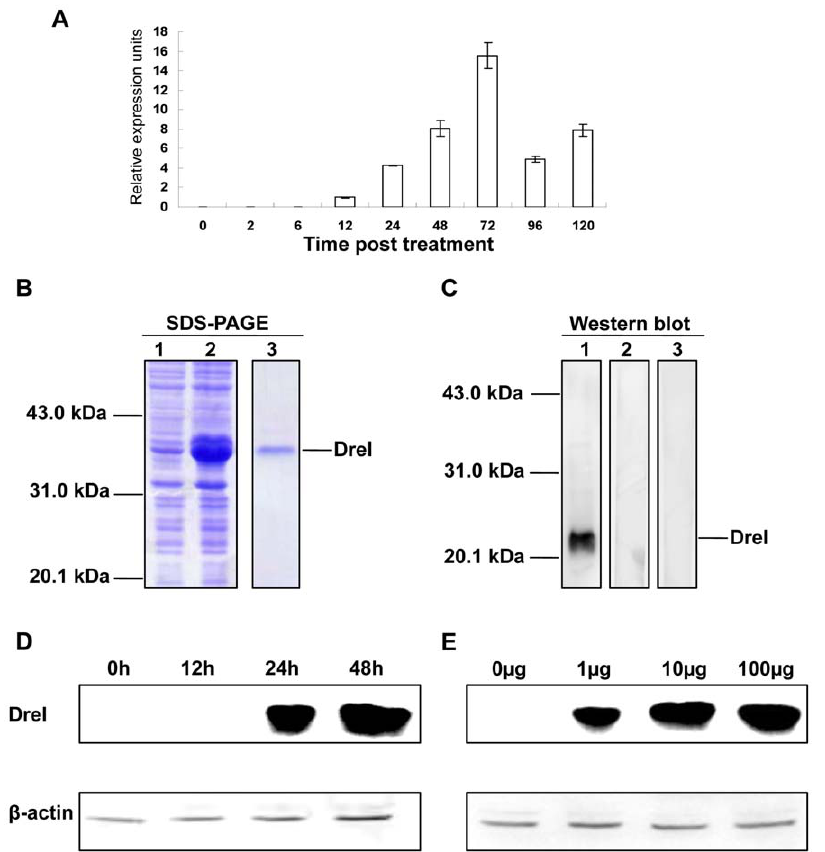
Figure 2. Inducible expression pattern of DreI . (A) ZFL cells seeded on 6-well plates overnight were transfected with 2 m g/ml poly I:C for 2, 6, 12, 48, 72, 96, and 120 h. Then total RNAs were extracted to examine the expression level of DreI transcripts by real-time PCR. b -actin was introduced as endogenous control. (B) Prokaryotic expression of the fusion protein DreI-His and generation of anti-DreI polyclonal antibody. Lane 1: lysate of normal bacteria; lane 2: lysate of IPTG-induced bacteria; lane 3: the purified protein by Ni 2 + -NTA affinity chromatography. (C) Transfection of ZFL cells with 2 m g/ml poly I:C for 48 h, the lysate was immunoblotted by polyclonal anti-DreI antiserum (lane 4), normal rabbit serum (lane 5) or anti-DreI antiserum pre-adsorbed with purified prokaryotic protein (lane 6). (D) ZFL cells were stimulated with 2 m g/ml poly I:C plus 4 m l/ml Lipofectamine 2000 for 12, 24, and 48 h, then lysed and detected by anti-DreI antiserum. b -actin served as an internal control. (E) For dose-dependent analysis, ZFL cells were treated with 1, 10, and 100 m g/ml poly I:C for 24 h. b -actin served as an internal